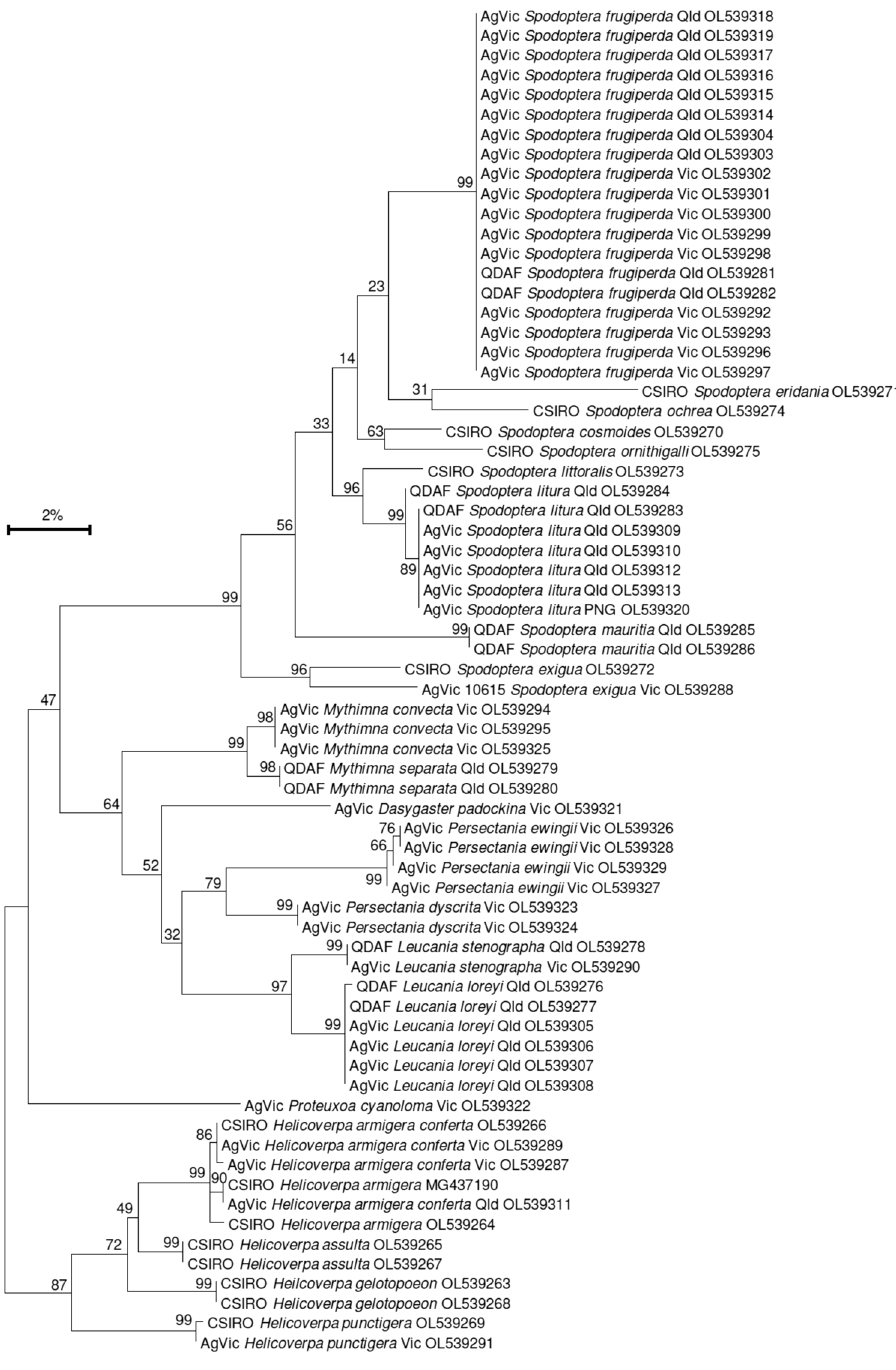
Figure 1. Maximum Likelihood tree (5 ′ -COI DNA sequences) of samples used for testing FAW LAMP assay. Bootstrap values indicated on nodes. AgVic, Agricultural Victoria; CSIRO, Commonwealth Scientific and Industrial Research Organisation; QDAF, Department of Agriculture and Fisheries Queensland; Vic, Victoria Australia; Qld, Queensland Australia; PNG, Papua New